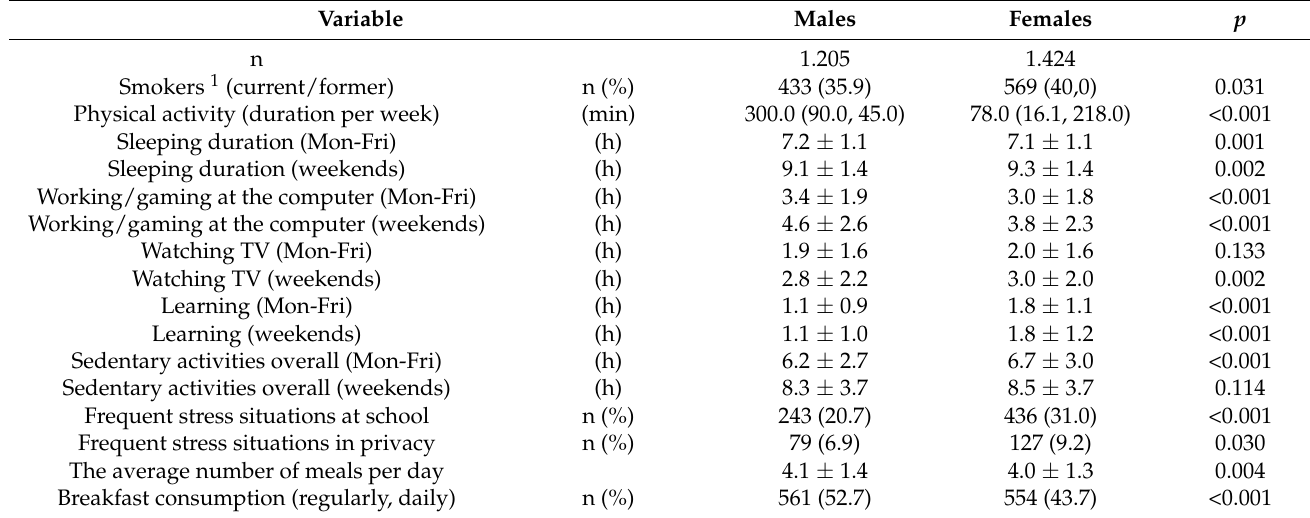
Table 2. Selected lifestyle characteristics and eating habits in males and females (n =